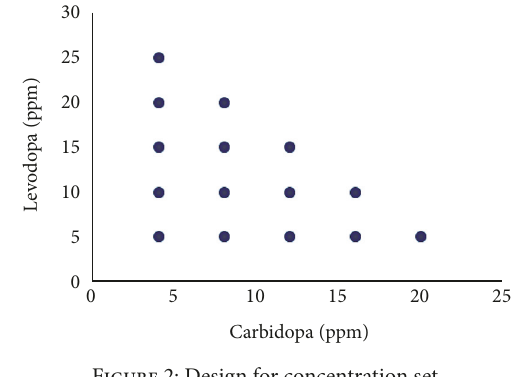
Figure 2: Design for concentration set.